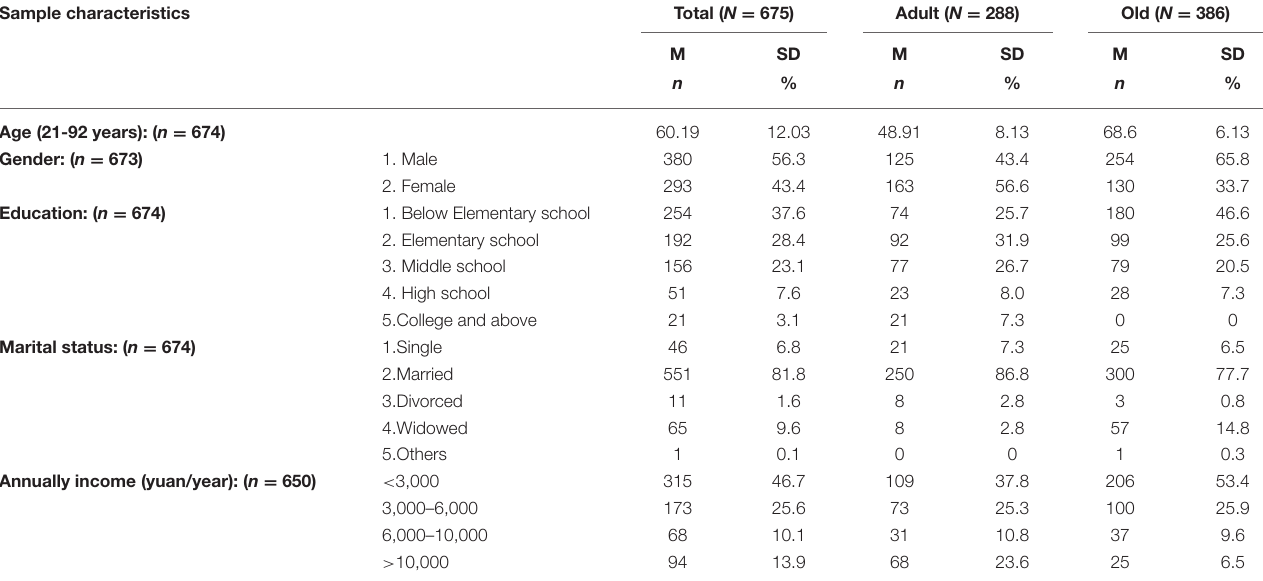
TABLE 1 | Sample characteristics (olds: ≥ 60). Sample